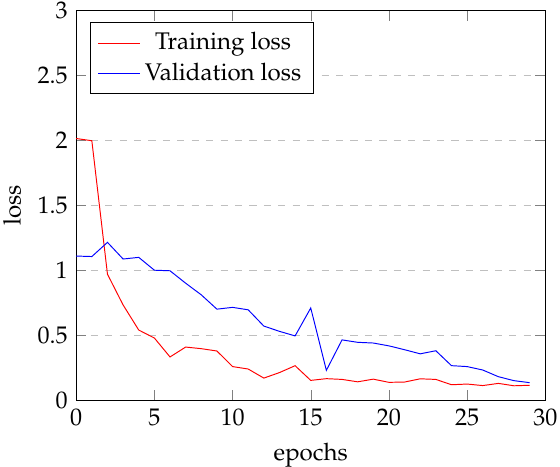
Figure 10. Training and validation losses for sequence-only